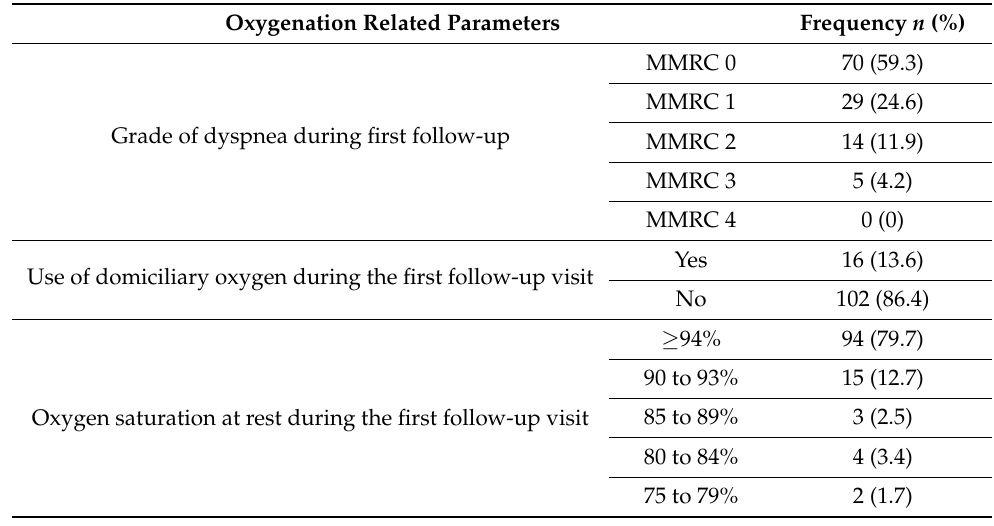
Table 5. Oxygenation status of post-COVID-19 patients presenting to follow-up OPD at STIDH (N-118).